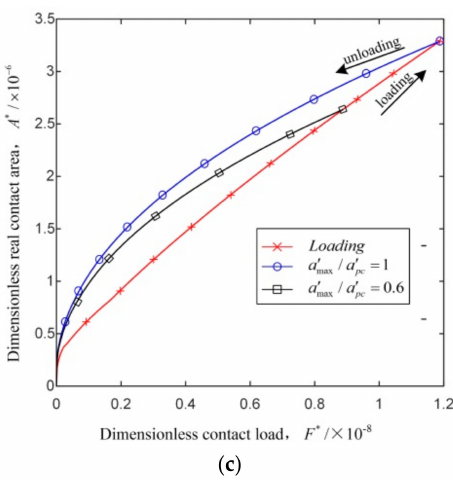
Figure 2. The relation between dimensionless real contact area and dimensionless contact load of two cylindrical surfaces in di ff erent deformation stages with D = 1.5, G = 10 − 10 mm, R c1 = 100 mm and R c2 = 60 mm. ( a ) The load–unload cycle in the elastic stage; ( b ) the load–unload cycle in the first elastoplastic stage; ( c ) the load–unload cycle in the second elastoplastic stage.